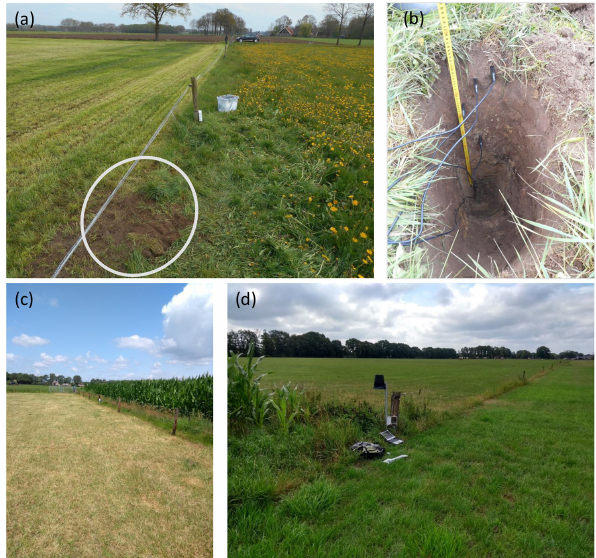
Figure 3. Photos taken of (a and b) the reinstallation of ITC_SM03 on 2 May 2017, (c) ITC_SM18 on 17 July 2019, and (d) ITC_SM02 on 17 July